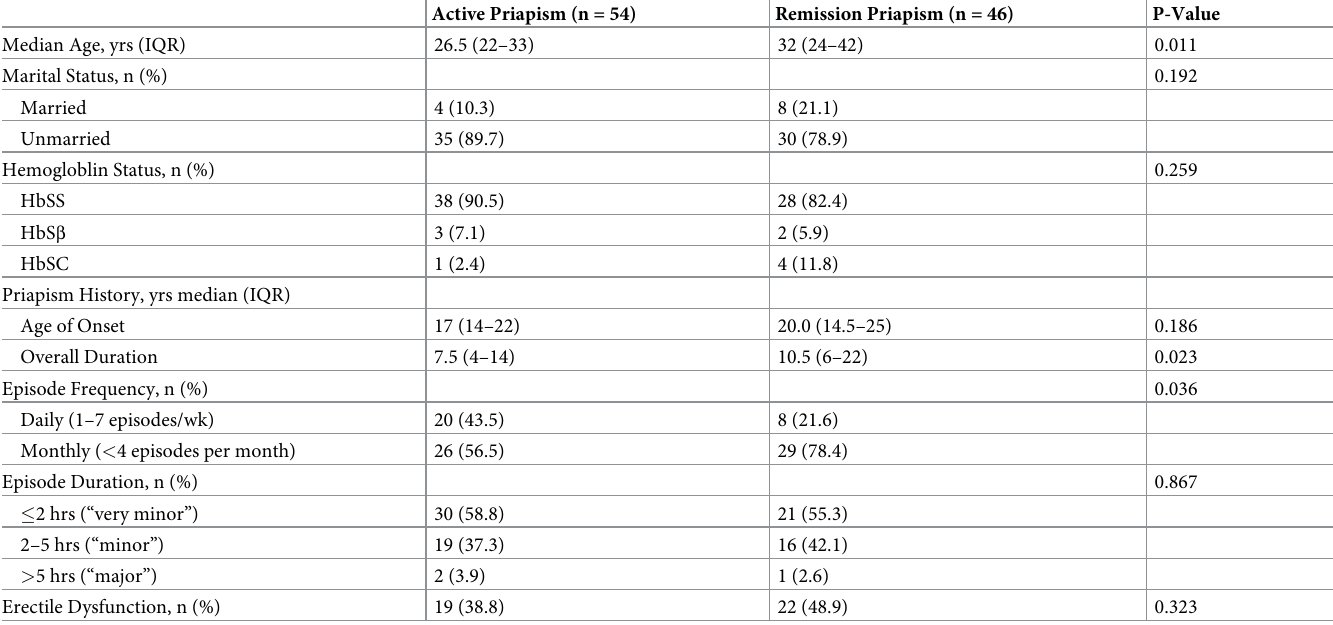
Table 1. Demographic and clinical characteristics of active and remission priapism